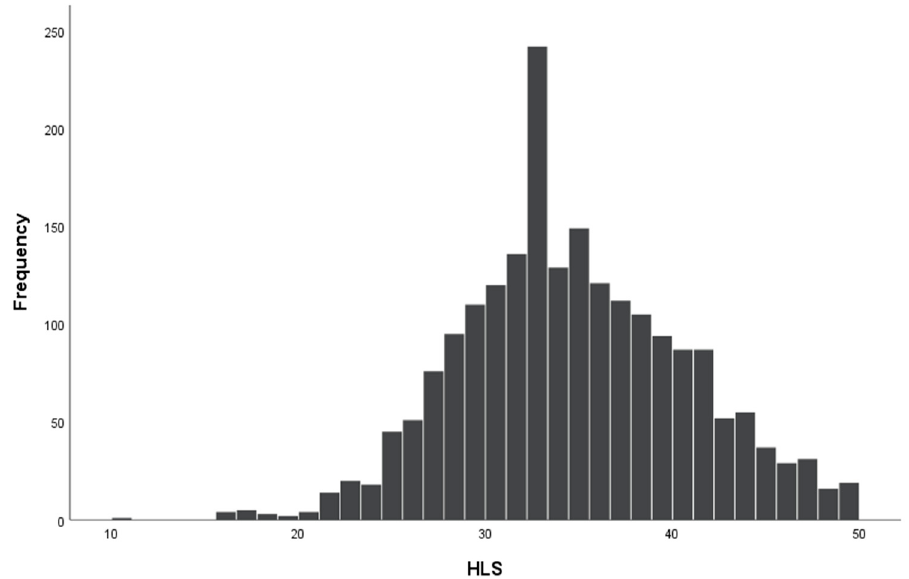
Figure 1. The distribution of HL score values in the study sample.